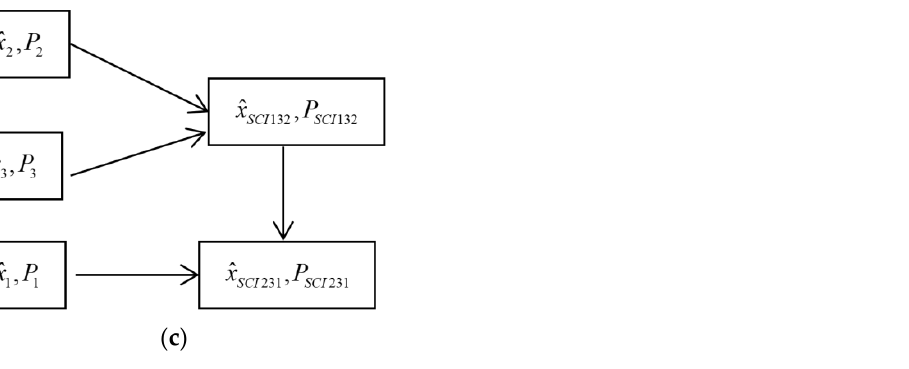
Figure 2. the fused orders of the SCI fusers in the 3 L  case. ( a ) The order 1: SCI123; ( b ) The Figure 2. The fused orders of the SCI fusers in the L = 3 case. ( a ) The order 1: SCI123; ( b ) The order order 2: SCI132; ( c ) The order 3: SCI231. 2: SCI132; ( c ) The order 3: SCI231.